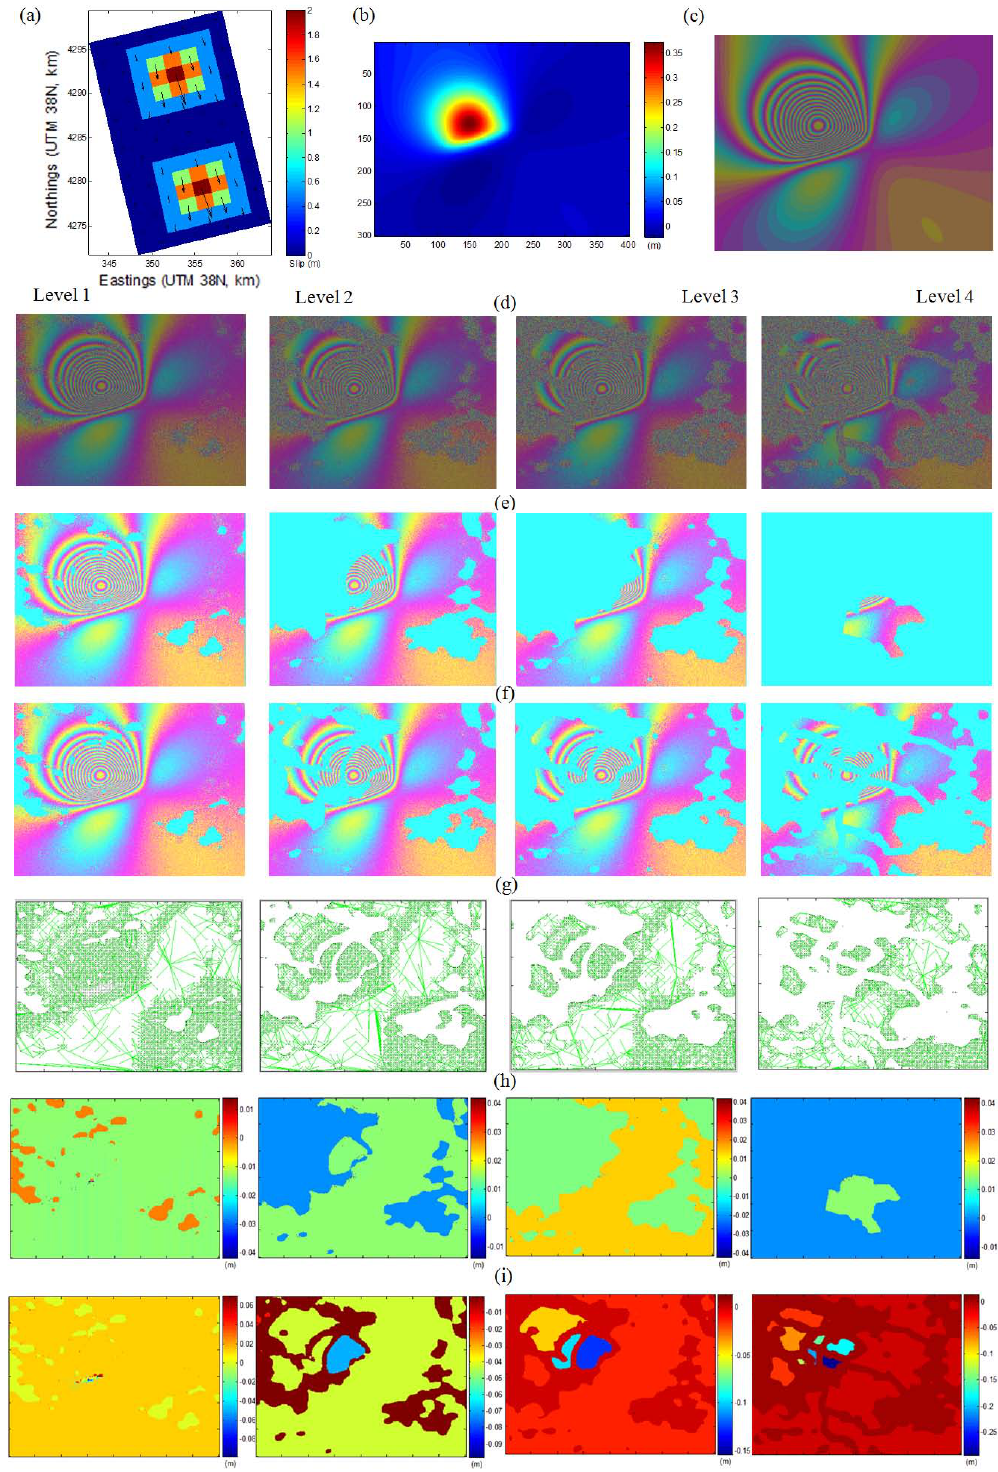
Fig. 2. (a) Assigned initial slip distribution. (b) Simulated displacement in ascending Envisat line of Sight. (c) Simulated interferogram. (d) The interferograms after adding different level of noises. The noises gradually increase from Level 1 to Level 4. (e) The unwrapped results from the branch cut algorithm. (f) The unwrapped results from the MCF algorithm. (g) The arcs used for inversion. (h) The difference between displacement unwrapped by the branch cut algorithm and the true displacement. (i) The difference between displacement unwrapped by the MCF algorithm and the true